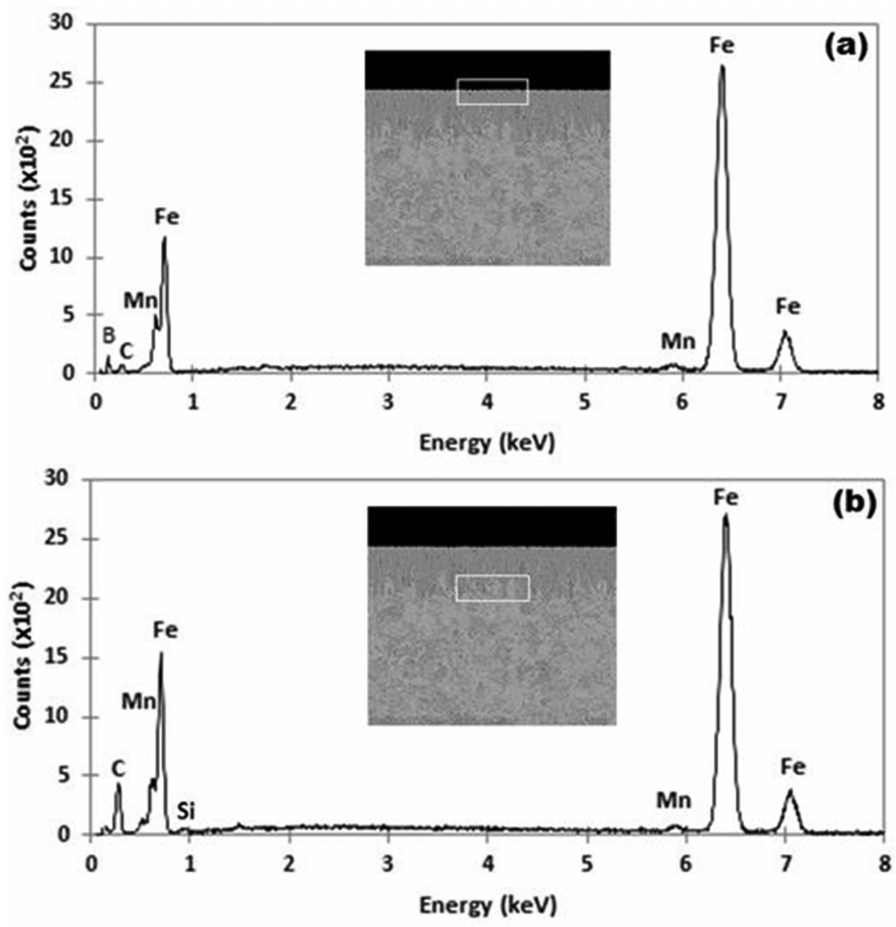
Figure 3: EDS spectra on the SEM micrograph of the cross-section of borided AISI 1518 steel at 1173 K for 8 h. (a) EDS spectrum obtained at the surface, (b) EDS spectrum obtained at the (Fe 2 B/substrate)